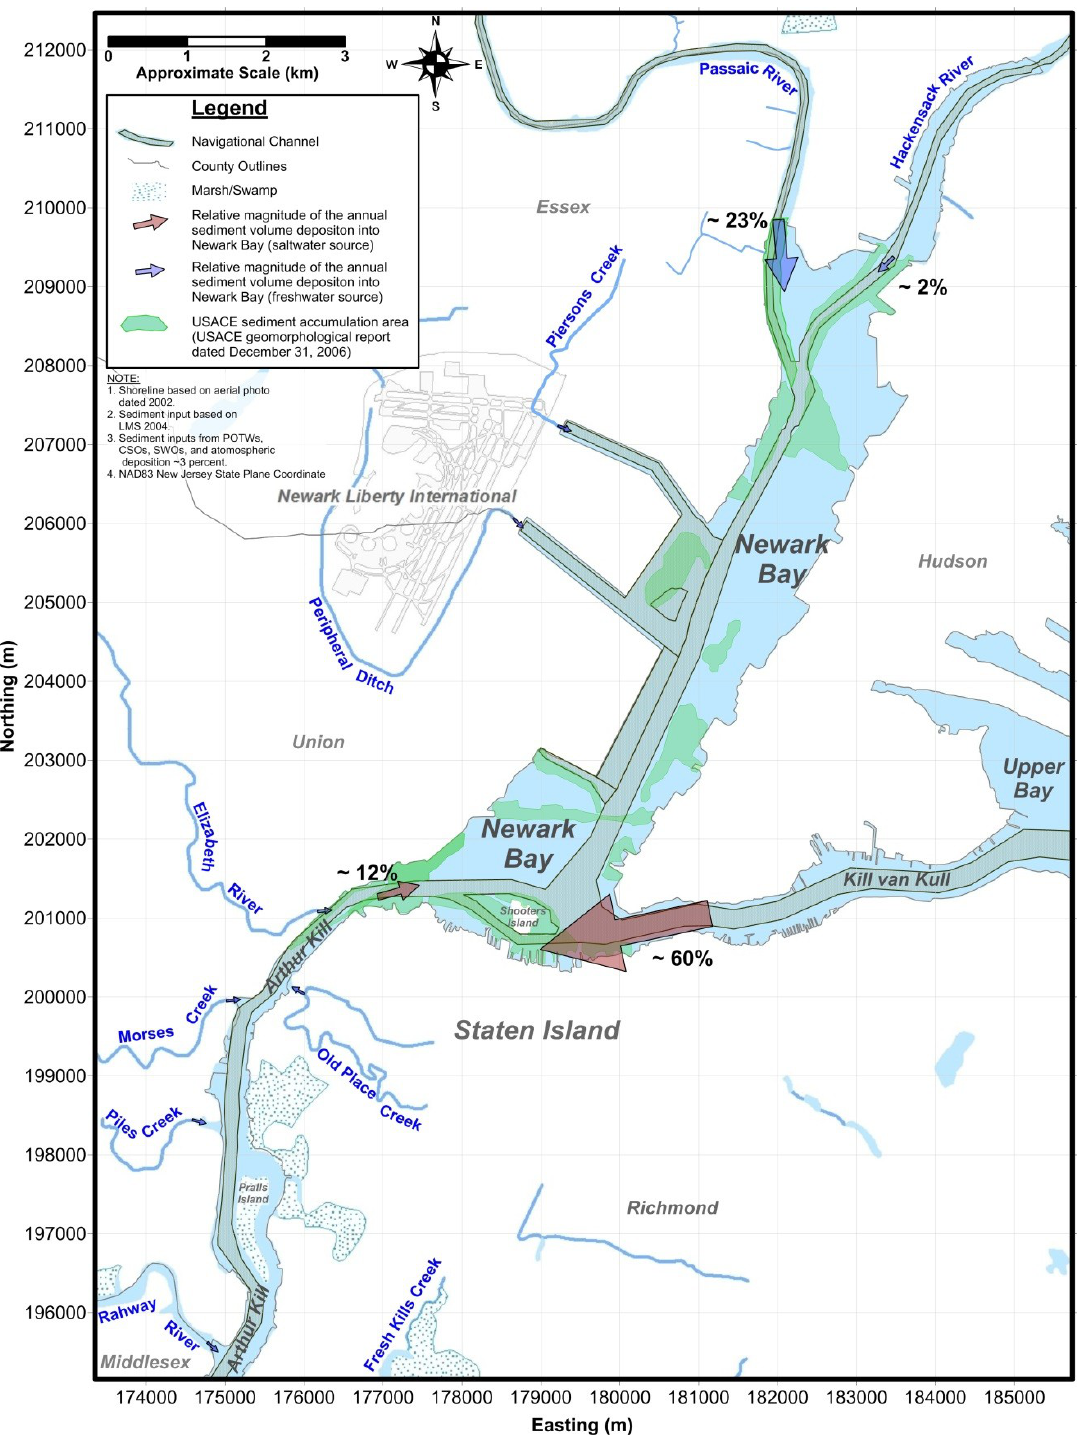
Figure 5. Sediment loads to the NBSA where the size of the arrows reflects the relative magnitude of sediment